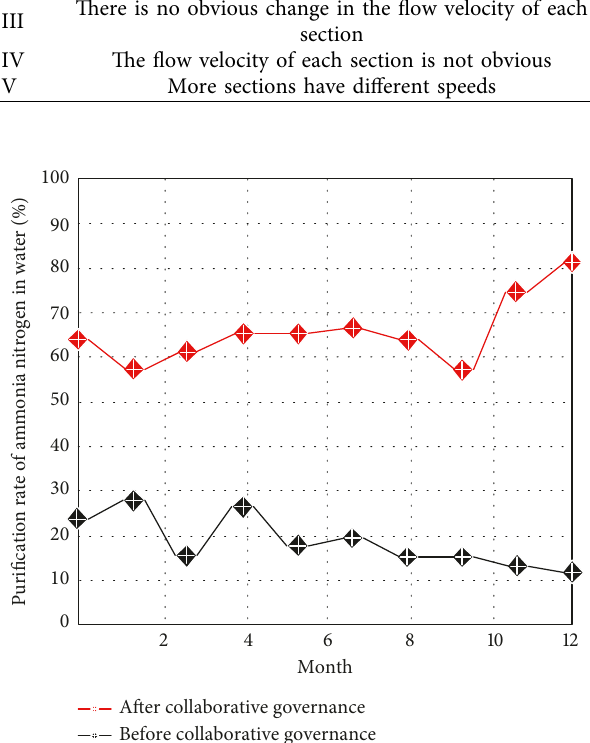
Figure 4: Comparison results of ammonia nitrogen purification rate in water pollution before and after